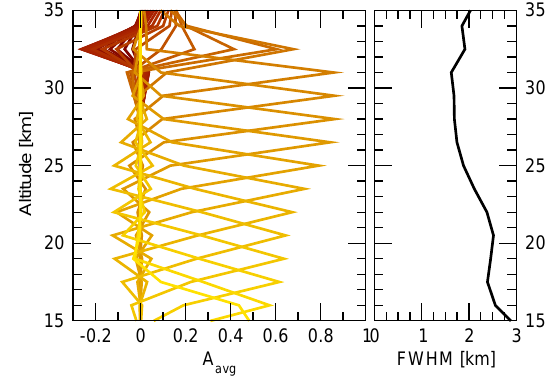
Fig. 8. On the left the averaging kernel for ClO is depicted with the corresponding FWHM on the